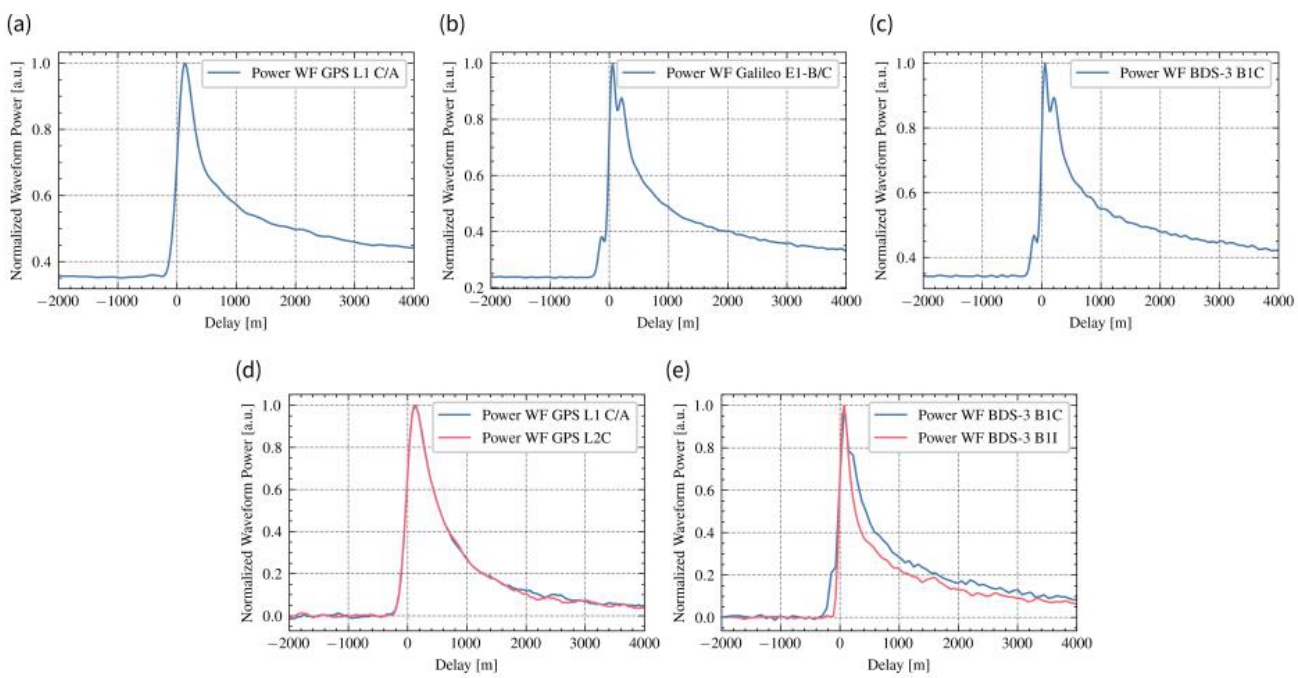
Figure 6. Examples of GNSS-R waveforms processed from multi-mission Spaceborne Raw IF data sets. ( a ) Normalized power waveform of reflected GPS L1 C/A signal (GPS PRN 16), the raw IF data is collected by CYGNSS FM04 on 17 November 2020. ( b ) Normalized power waveform of reflected Galileo E1 BC signal (Galileo PRN 14), the raw IF data is collected by CYGNSS FM08 on 13 October 2018. ( c ) Normalized power waveform of reflected BDS-3 B1C signal (BDS-3 PRN 30), the raw IF data is collected by CYGNSS FM07 on 11 October 2018. ( d ) Comparison between normalized power waveforms of reflected GPS L1 C/A and L2C signals (GPS PRN 27), the raw IF data of GPS L1 and L2 signals is collected simultaneously by SPIRE GNSS RO satellite (FM115) on 9 December 2020. ( e ) Comparison between normalized power waveforms of reflected BDS-3 B1C and B1I signals (BDS-3 PRN 27), the raw IF data of BDS-3 B1I and B1C signals is collected simultaneously by BF-1A